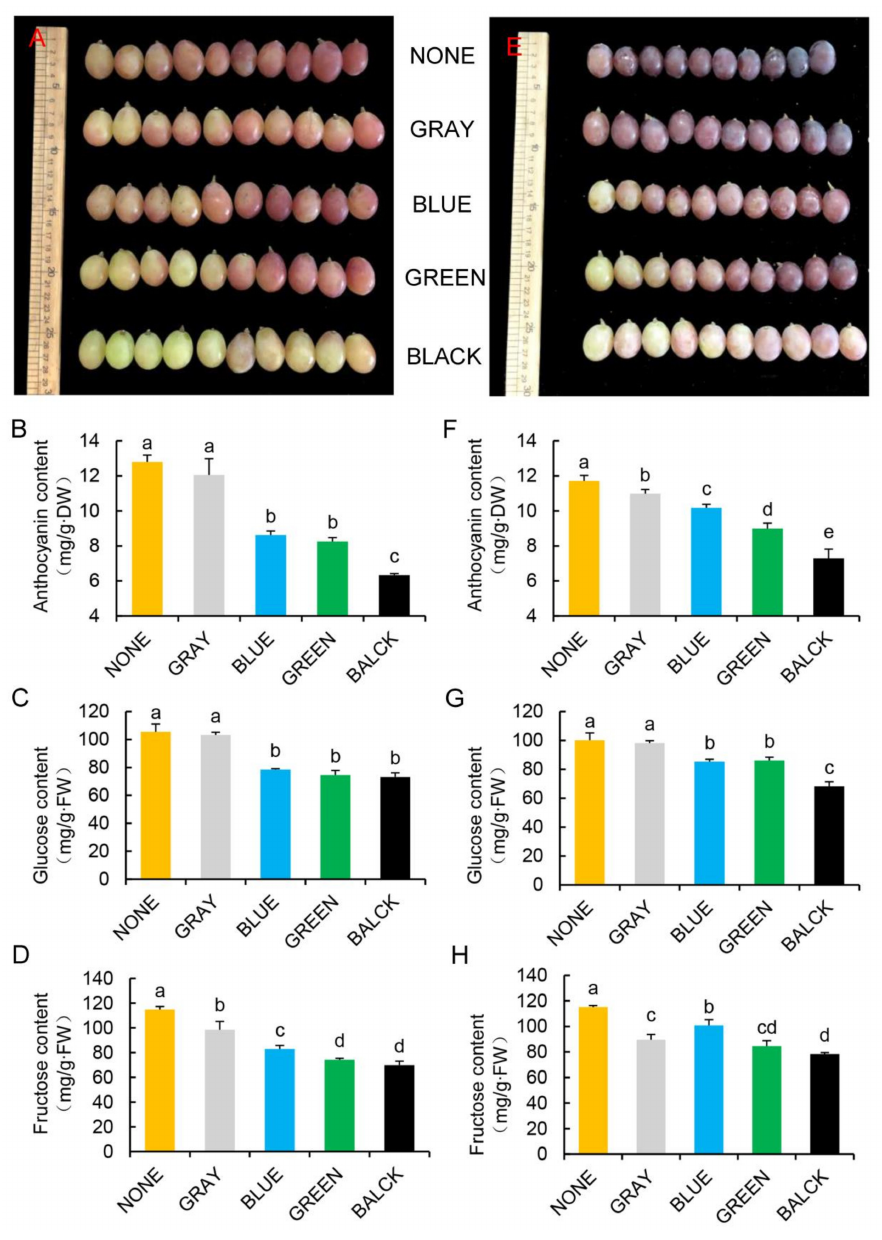
Figure 2. The grapes and their composition across the different treatments. ( A , E ): grape images; Antho- cyanin, glucose, and fructose levels at PQ ( B – D ) and ZH ( F – H ). NONE: no shading; GRAY, BLUE, GREEN, and BLACK: shade net colors. Different lowercase letters indicate significant differences ( p < 0.05). Table 3. Softening index of the “Jumeigui” grape